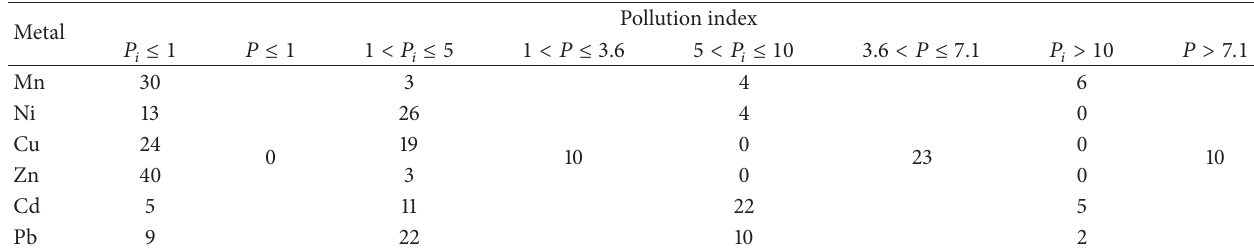
Table 5: Evaluation of the metal pollution